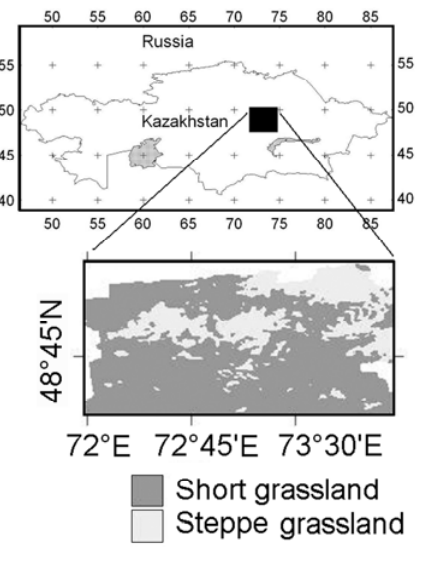
Figure 1. Location of the study region on the map of Kazakhstan and distributions of land cover classes in the study region based on the MODIS land-cover map